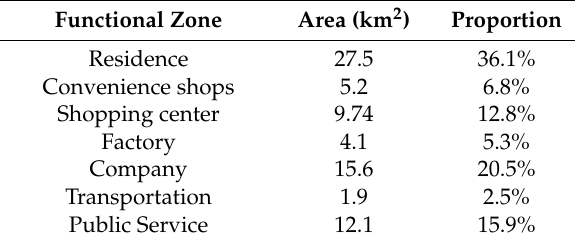
Table 4. Area and proportion of different functional